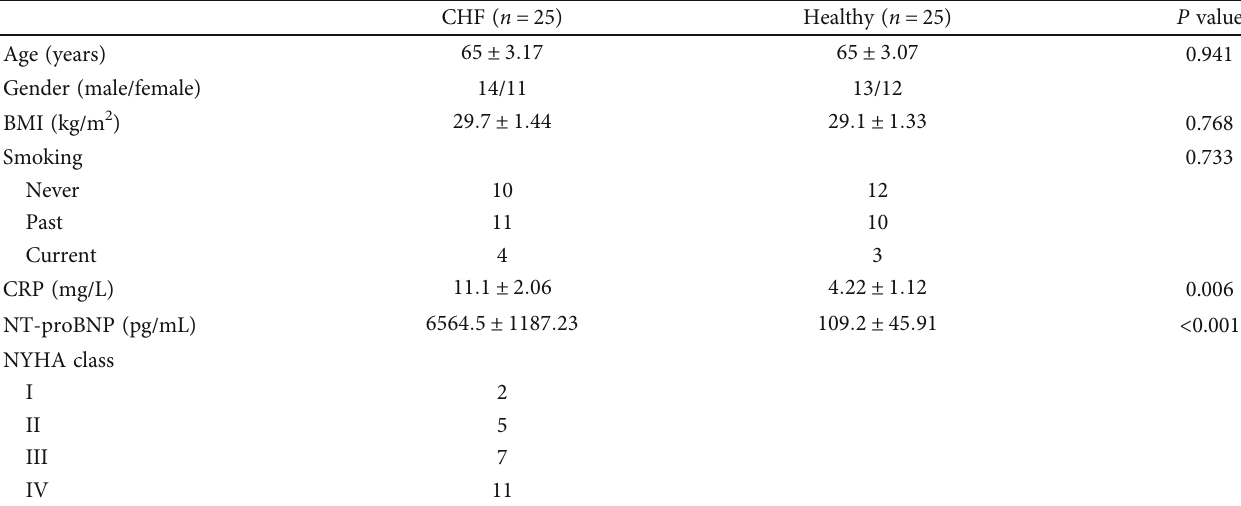
Table 1: Clinical parameters of